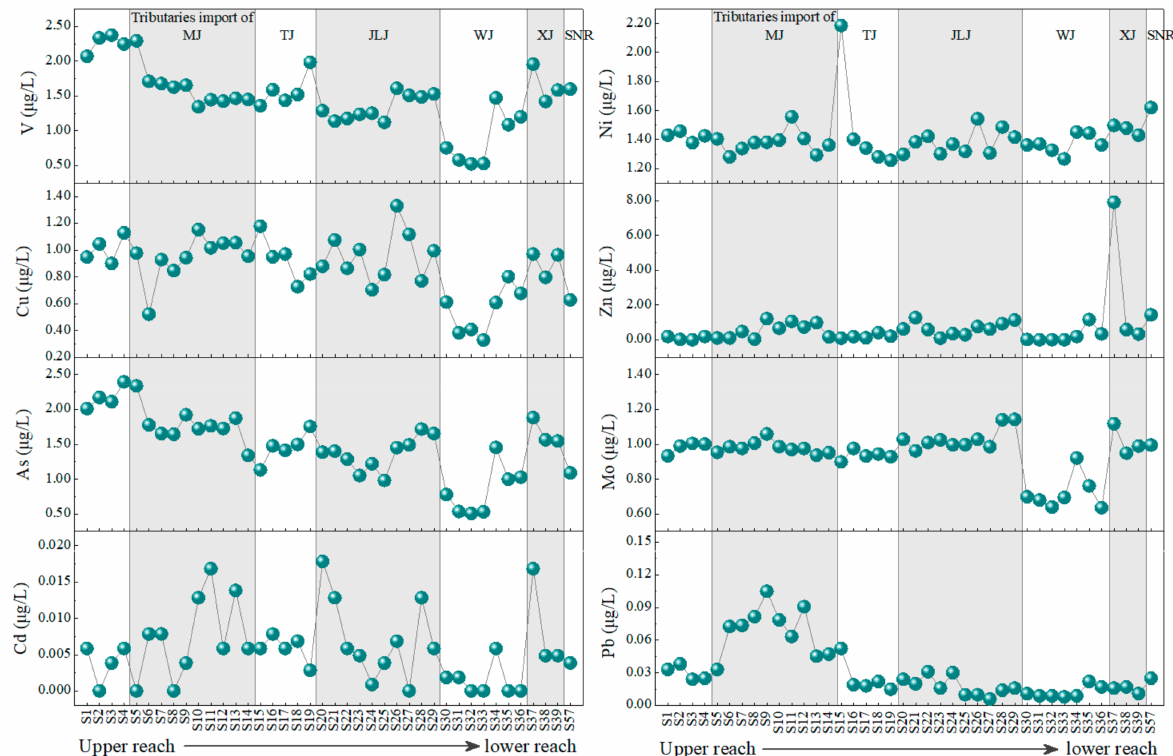
Figure 2. Spatial variations in concentrations of eight HMs at 40 sampling sites along the main channel of upper TGR